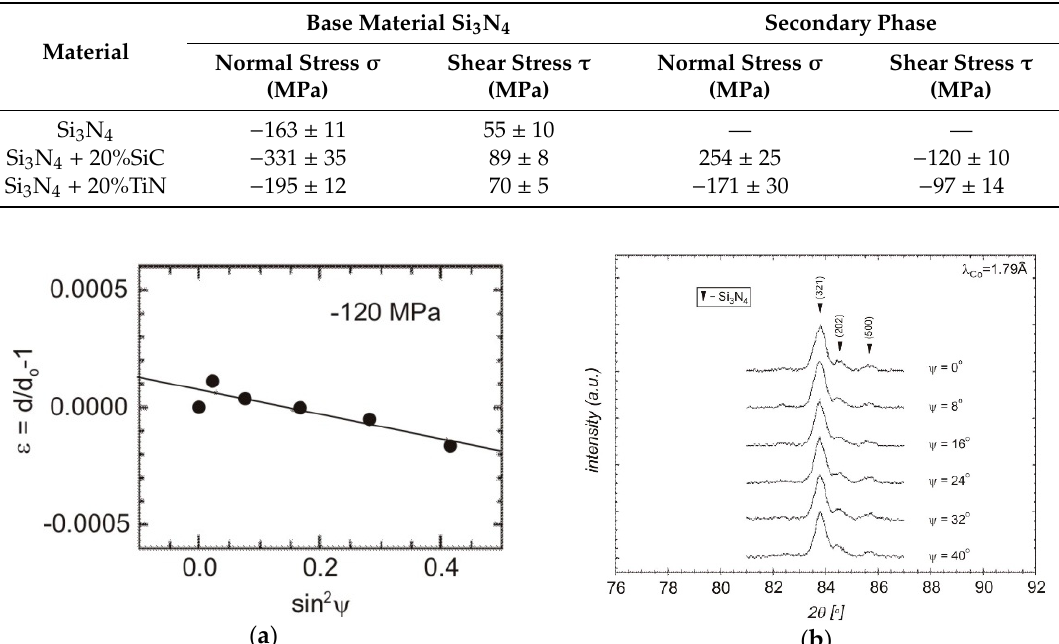
Table 6. Measured surface residual stresses in silicon nitride-based materials and secondary phases.